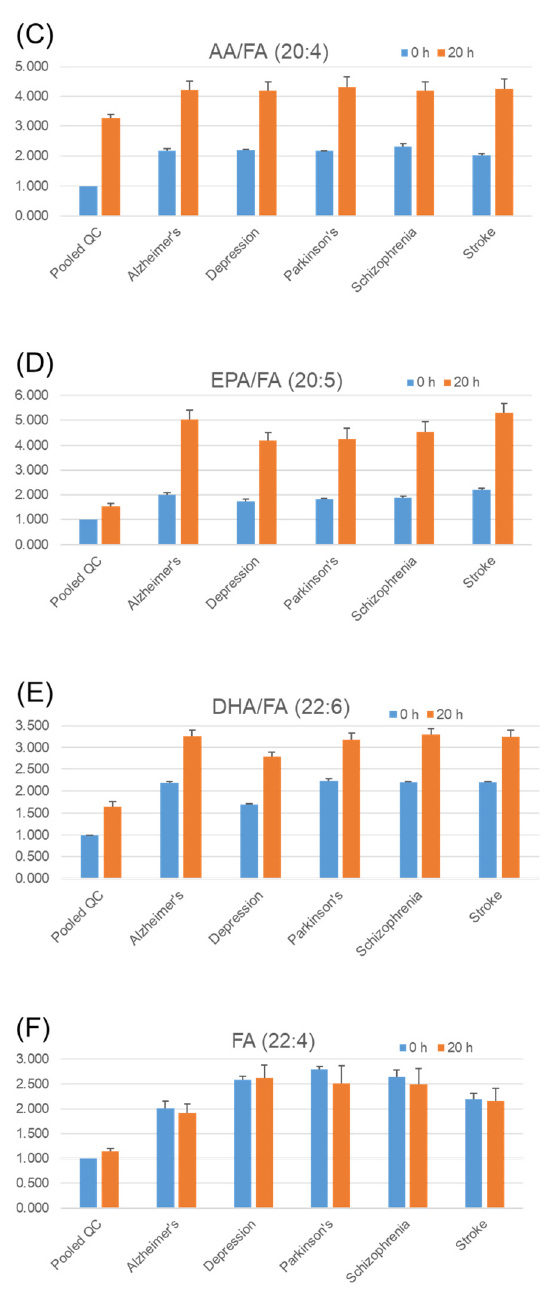
Figure 6. Stability of endogenous free fatty acids in serum. Pooled quality control (QC) serum samples and pooled disease serum samples were incubated at 37 °C for 20 h. Three replicates of each pooled serum sample were tested. Extraction, tandem mass tag (TMT) derivatization, and LC/MS analysis were performed as described in the Methods section. The Y -axis shows the values relative to those of pooled QC serum with no incubation (0 h) for each lipid. Error bars represent the standard error of the mean. FA, fatty acid; AA, arachidonic acid; EPA, eicosapentaenoic acid; DHA, docosahexaenoic acid. ( A ) FA (18:1), ( B ) FA (20:1), ( C ) AA/FA (20:4), ( D ) EPA/FA (20:5), ( E ) DHA/FA (22:6), ( F ) FA (22:4).